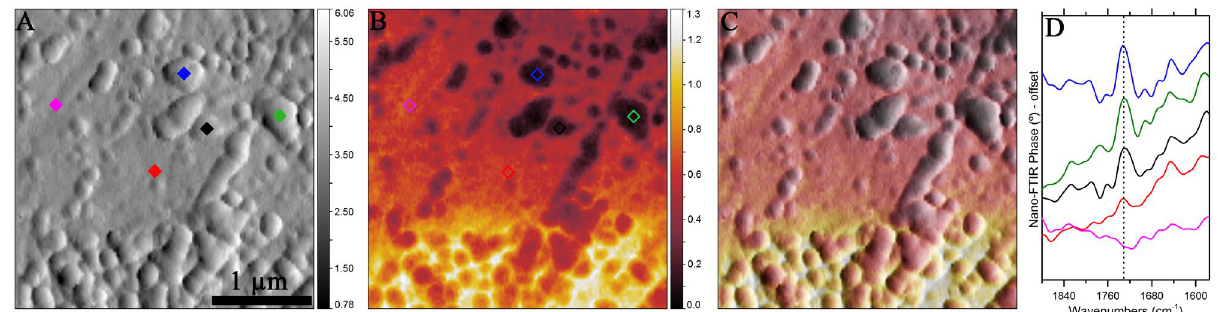
Figure 3. Nano-FTIR spectroscopic investigation of another location in DOM 08006. ( A ) Mechanical and ( B ) optical amplitude images of the measured area. Diamonds in ( A ) and ( B ) denote the points from where the spectra were collected. ( C ) Blended amplitude image clearly showing the roughly spherical carbonyl nanoglobules in DOM 08006. ( D ) Corresponding color-coded nano-FTIR spectra.